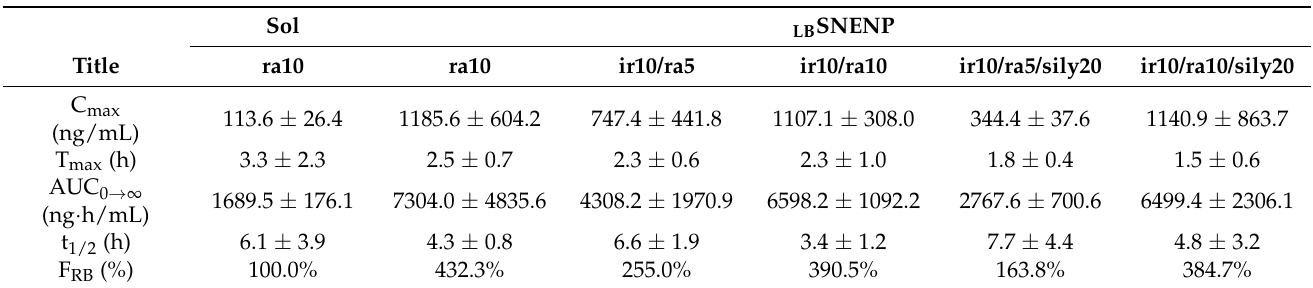
Table 10. PK parameter estimations of rapamycin after oral administration with Sol ra10 , LB SNENP ra10